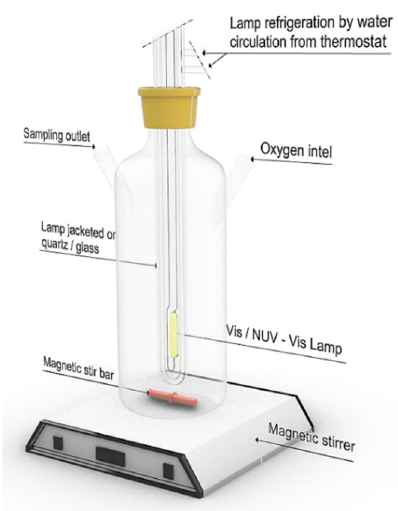
Figure 1. Scheme of the photoreactor used in heterogeneous photocatalysis experiments.